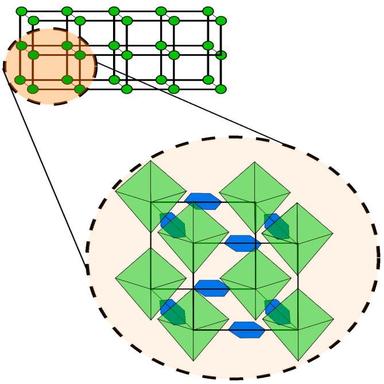
The number of MOF-related publications from 210 to 2020 (data was extracted from ScienceDirect website by searching the keyword "metalorganic framework").